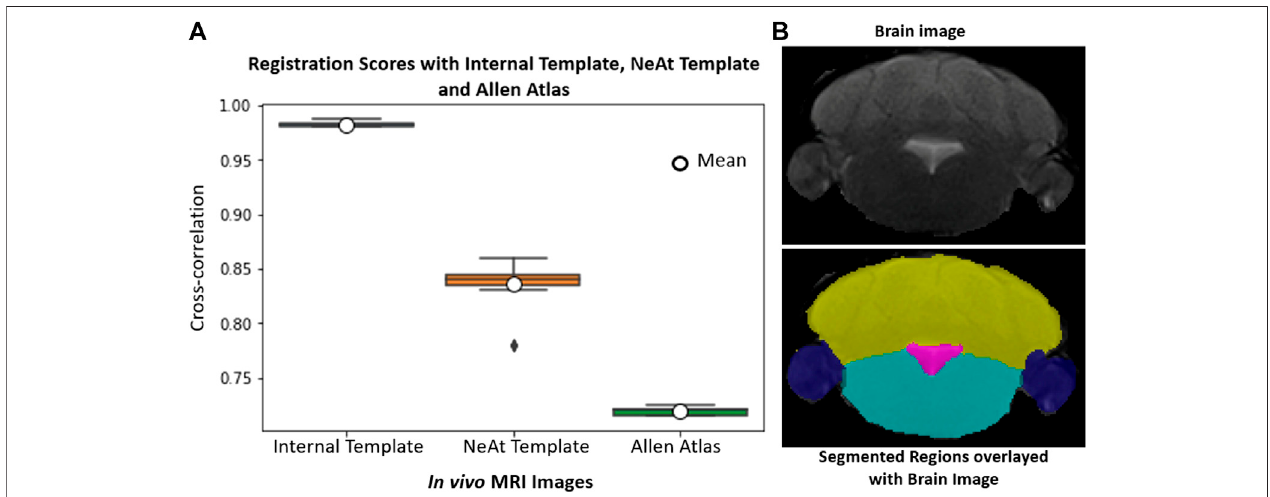
FIGURE 9 | In vivo whole-brain registration: (A) : Registration scores of 18 image volumes with our internal template, NeAt template/Atlas and Allen atlas. (B) : Samplevolumeusingtheskull-stripping/registrationparadigmwiththeinternal(in-house)generatedtemplateandsegmentedbrainstructures.Eachregionisdelineated with separate color; cerebellum (yellow), para fl occulus/ fl occulus (blue), ventricle (magenta), and brain stem (turquoise).